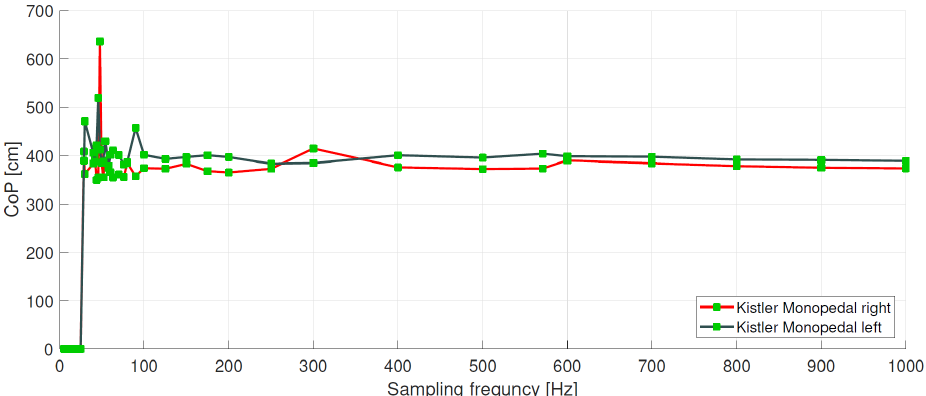
Figure 6. Absolute CoP length curve as a function of the sampling frequency used in the bipedal state, with open (EO) and closed eyes (EC), respectively.